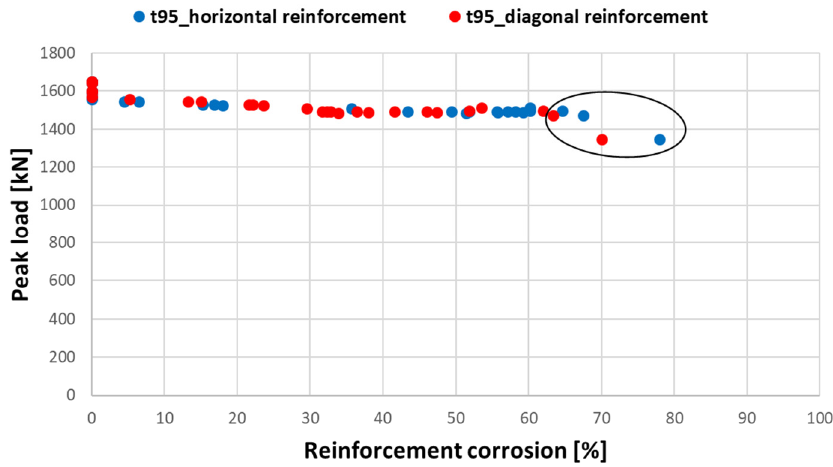
Figure 21. Correlation between peak load and reinforcement corrosion (t95).